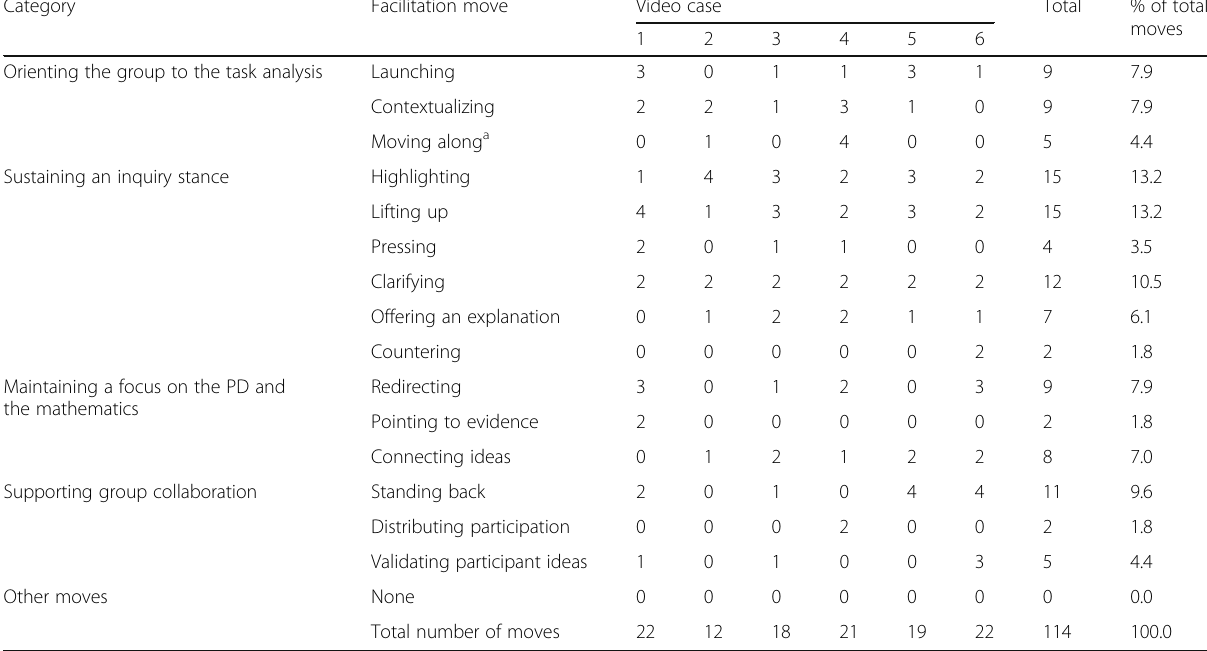
Table 6 Facilitation moves noticed in the video cases Category Orienting the group to the task